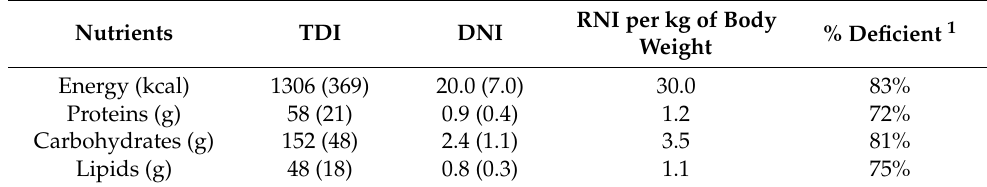
Table 3. Daily Nutrient Intakes (TDI and DNI) as compared to Recommended Nutrient Intake (RNI). Means are presented with their standard deviation (in parentheses).